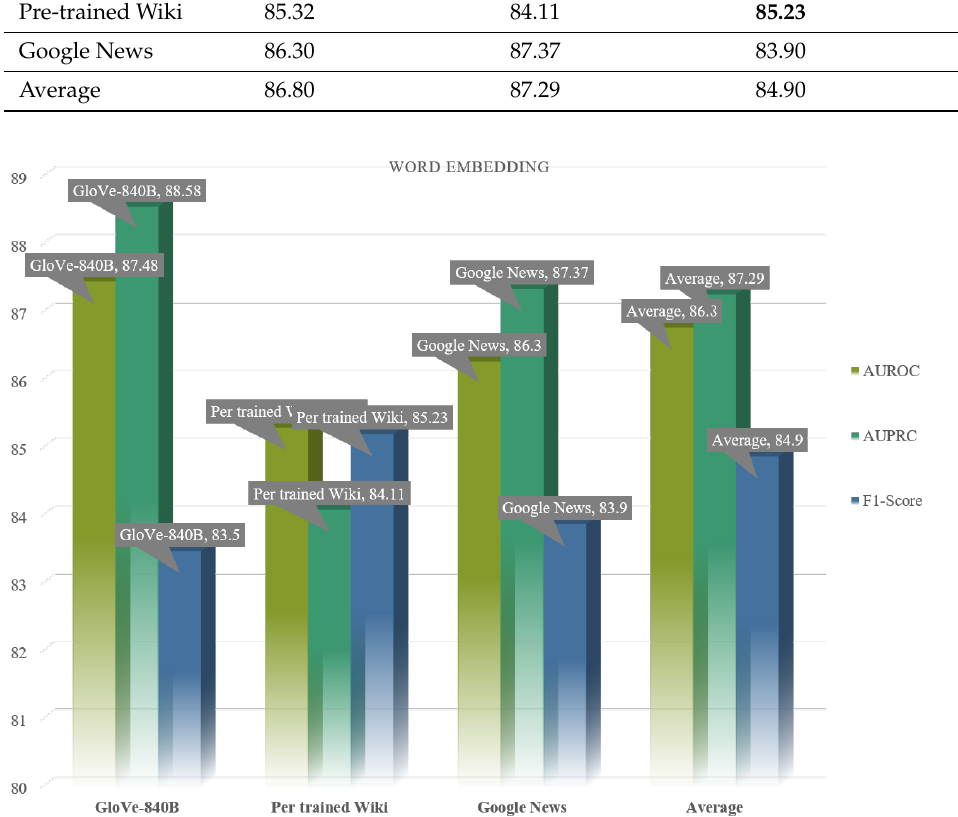
Table 4. Performance analysis of pre-trained-word embedding.